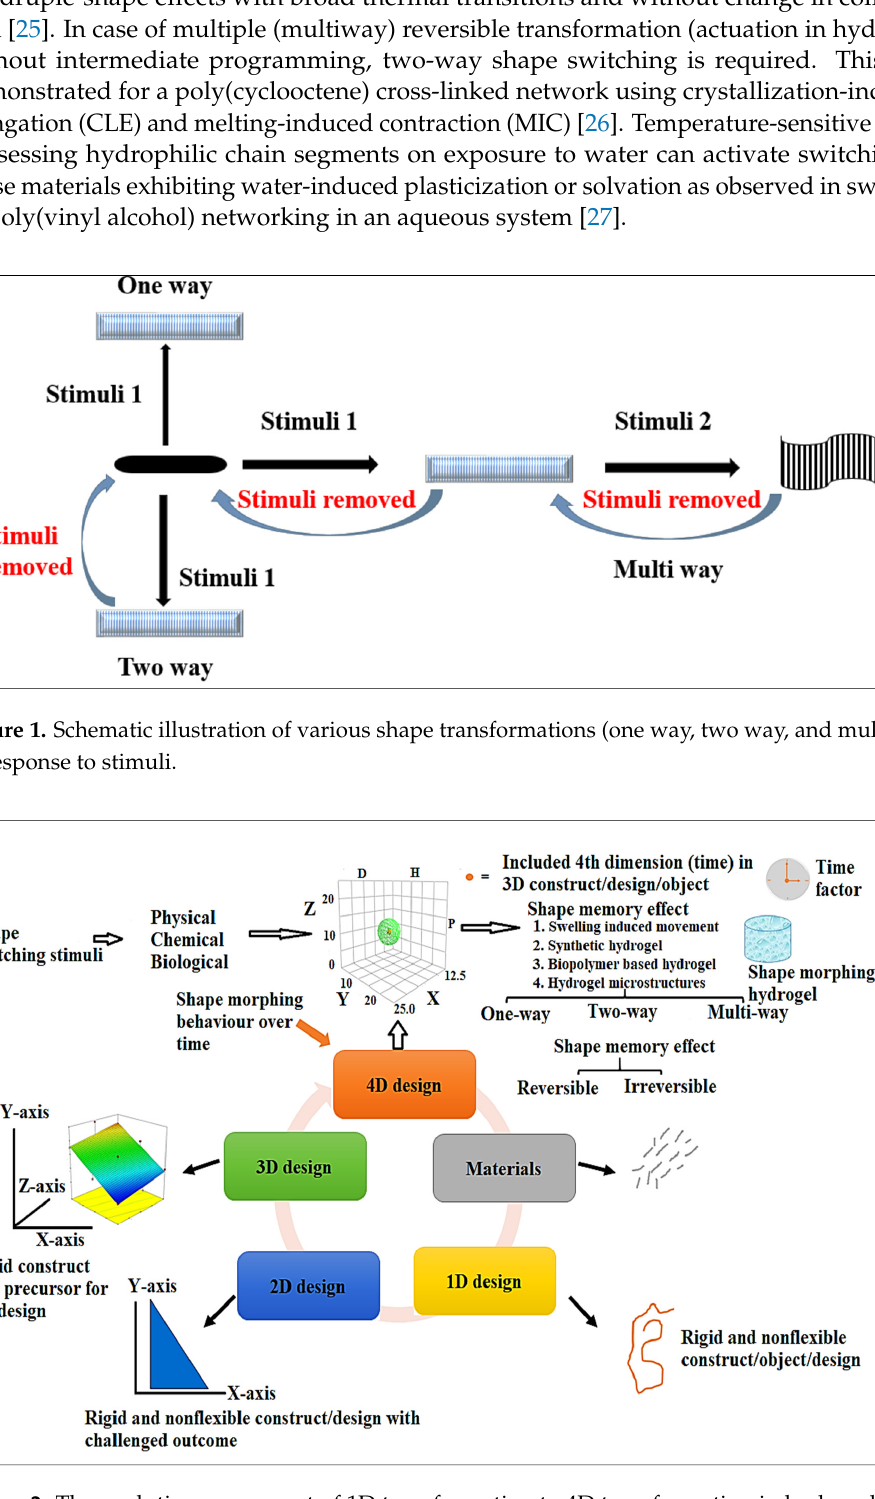
Figure 2. The evolutionary concept of 1D transformation to 4D transformation in hydrogel. Four dimensional design hy- drogel under several stimuli (shape-switching stimuli) to achieve temporary reversible/irreversible shape-memory effect (SME).